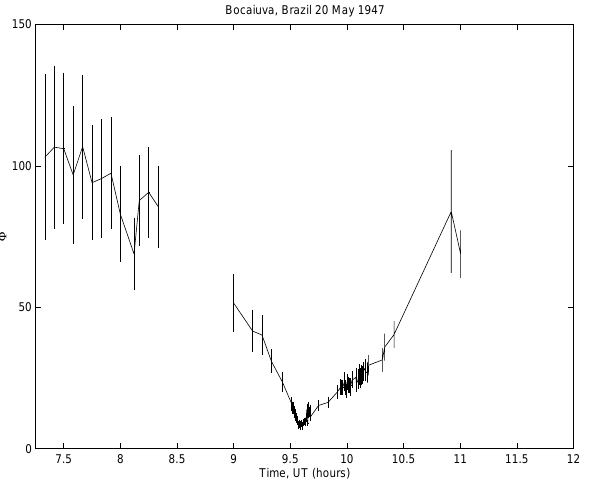
Fig. A4. The variation of 8 during the eclipse of 30 May 1965 at Aitutaki, Cook Islands, as calculated using Eq. (2) and the data shown in Fig.